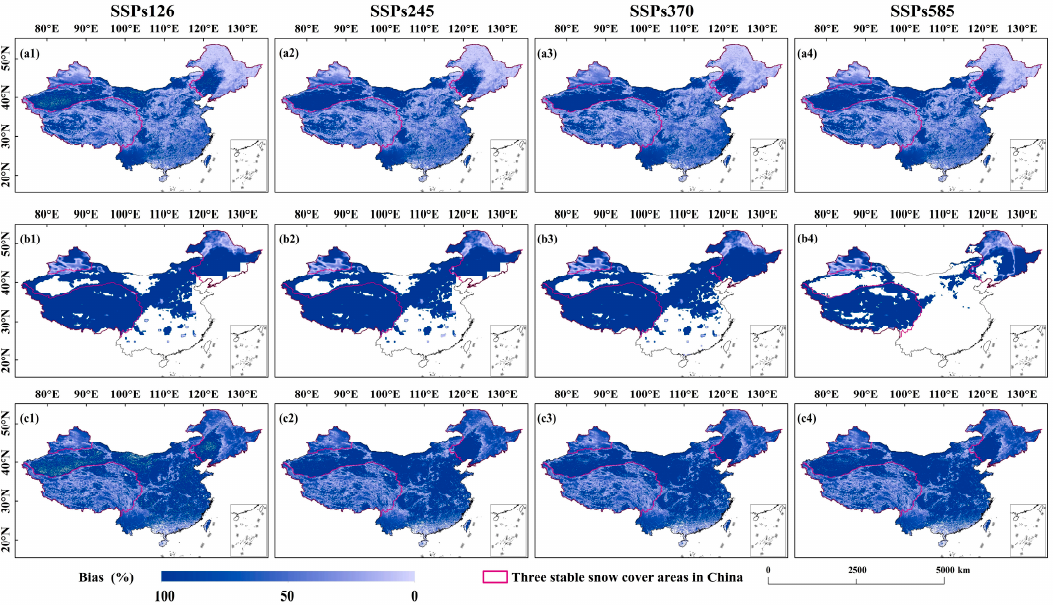
Figure 7. Spatial distribution of bias between CMIP6 and SCF ( a ), SD ( b ) and SCD ( c ) in the TP, NX, and NC under the SSPs126 ( a1 – c1 ), SSPs245( a2 – c2 ), SSPs370 ( a3 – c3 ) and SSPs585 ( a4 – c4 ) from 2015